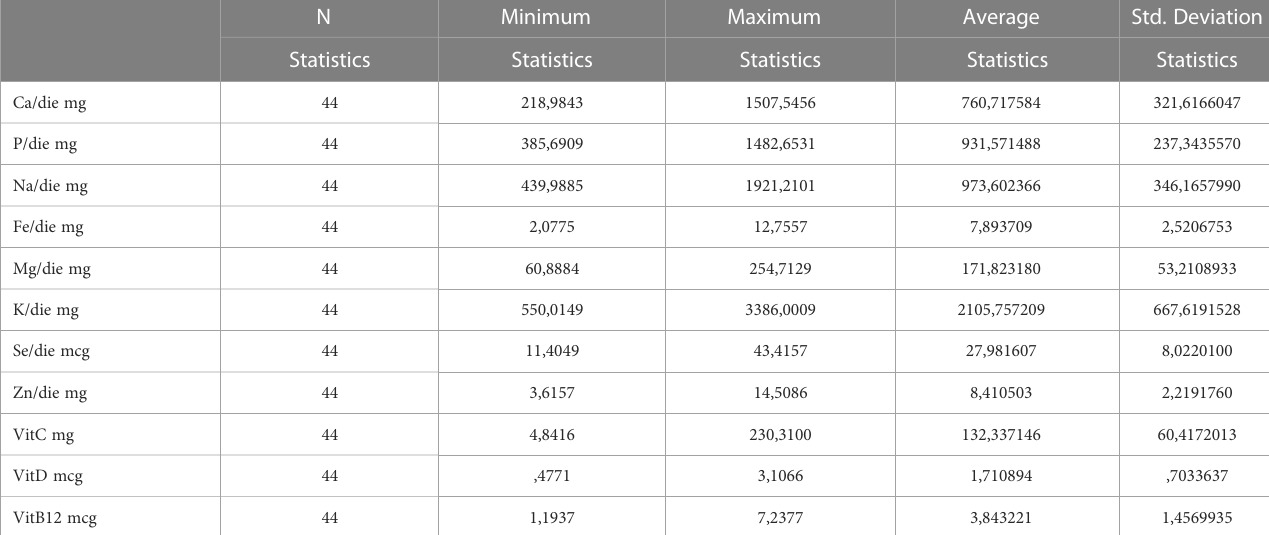
TABLE 8 Average intakes of the analyzed